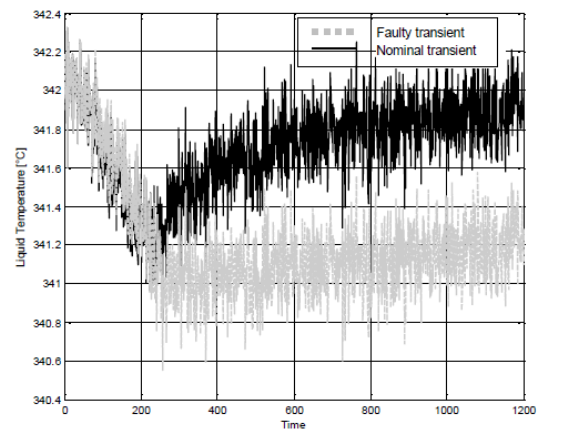
Fig. 16. Evolution of the liquid temperature for a nominal transient and the faulty transient.